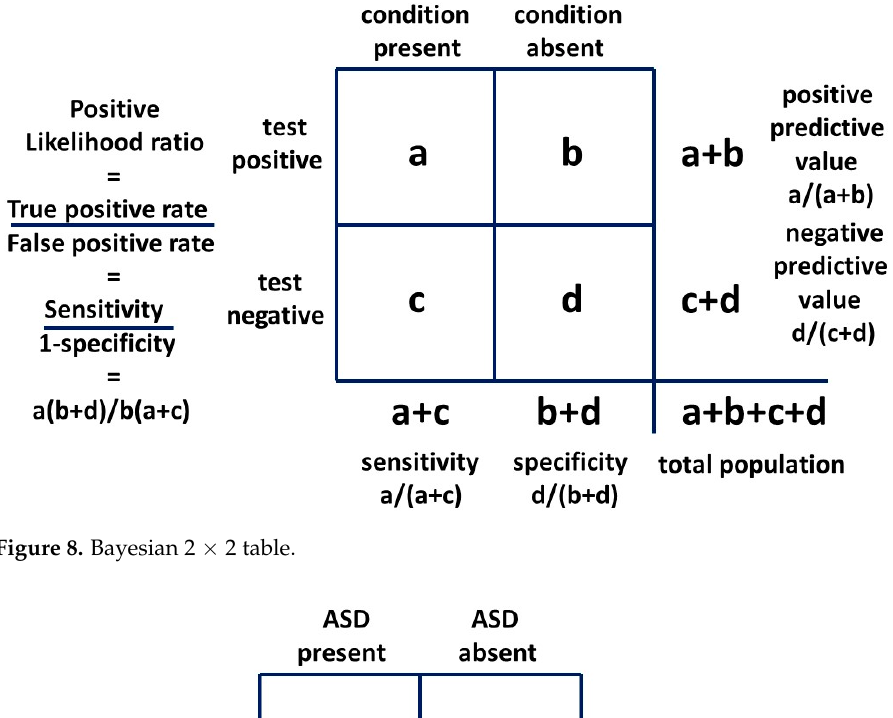
Figure 8. Bayesian 2 × 2 table.